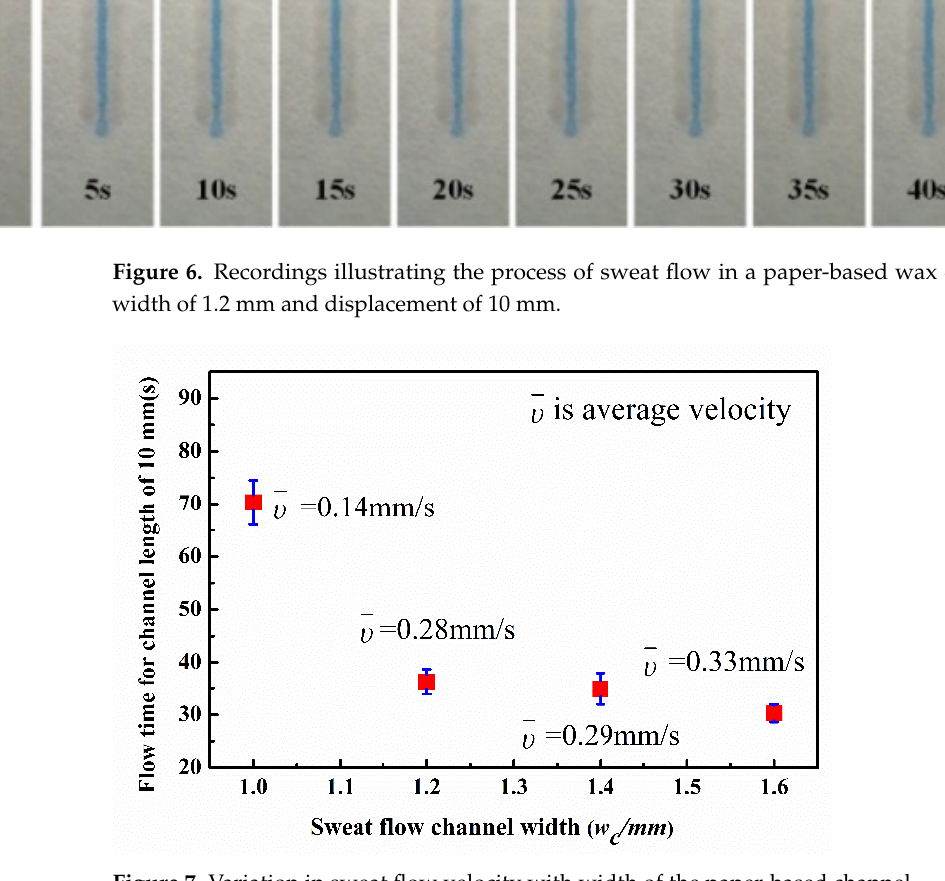
Figure 7. Variation in sweat flow velocity with width of the paper-based channel.